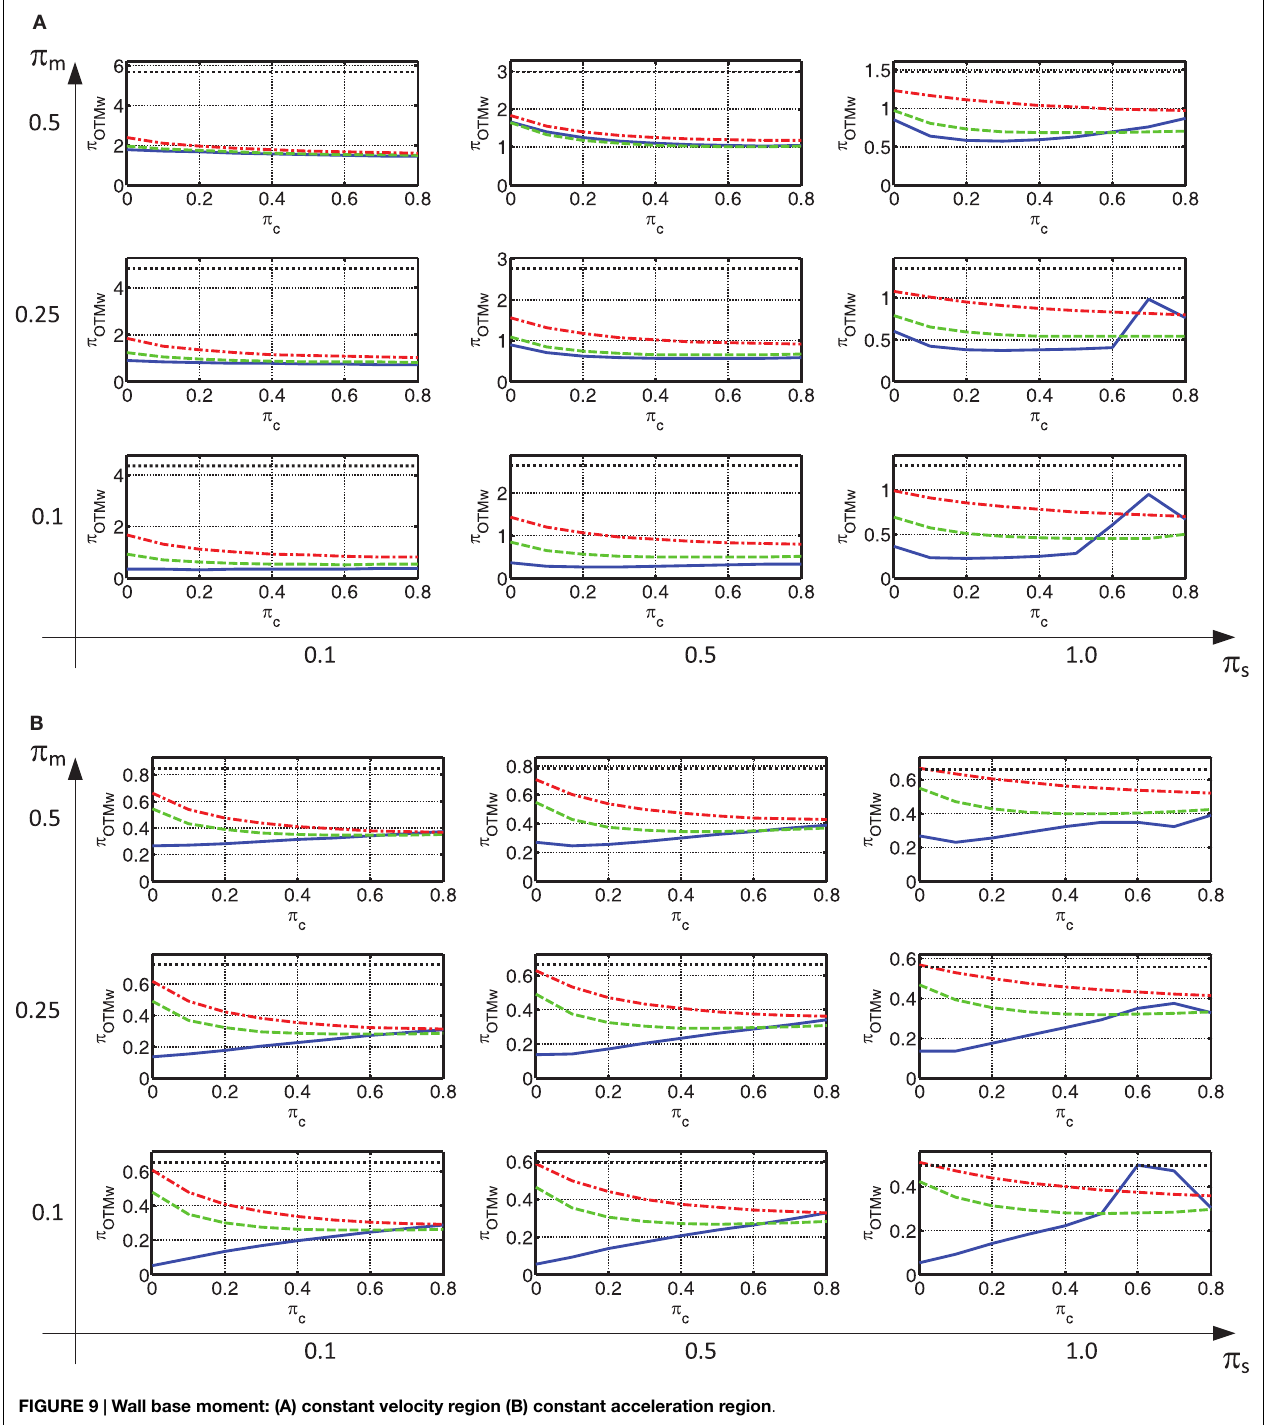
FIGURE 9 | Wall base moment: (A) constant velocity region (B) constant acceleration region .